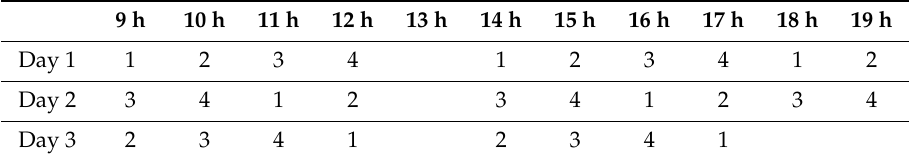
Table 1. Package presentation